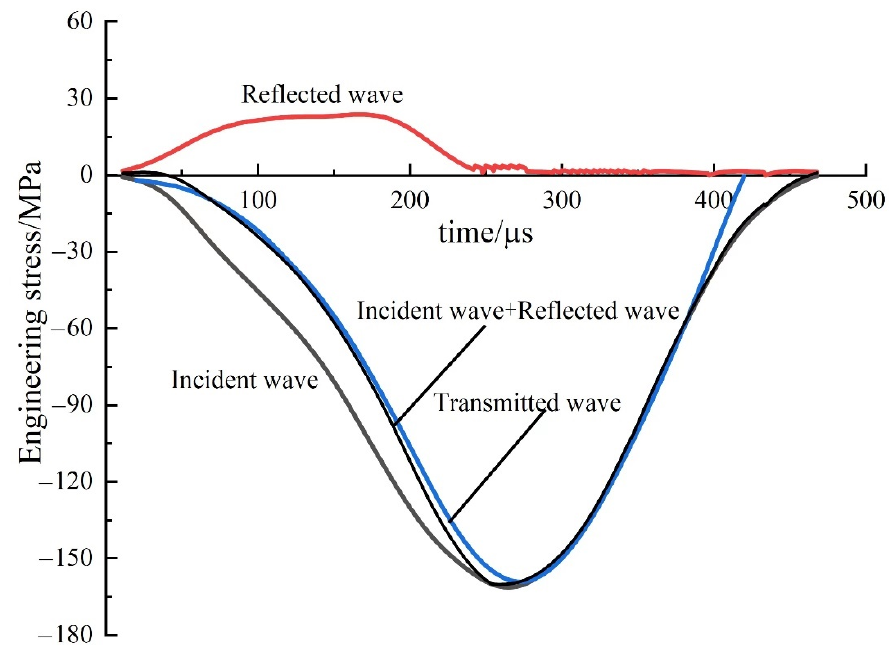
Figure 3. Typical response signals of incident, reflected and transmitted waves.